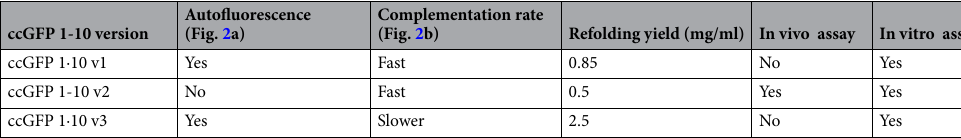
Table 1. Summary of three versions of ccGFP 1–10 and their suggested uses for in vivo and in vitro assays.